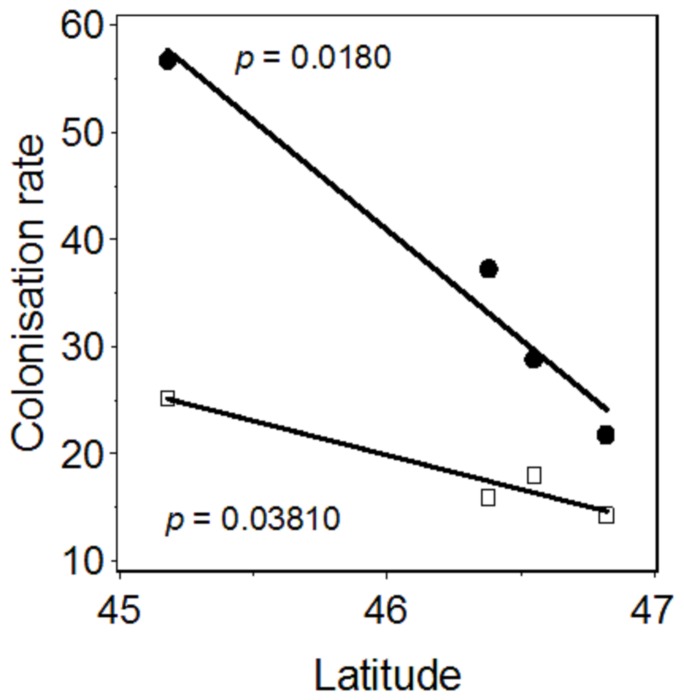
Colonisation rates (m year−1) as a function of the latitude (°) of the studied forests.Maximum (closed circle) and mean (open square) values were estimated for each forest. The P-values indicated are those for linear regression analysis.